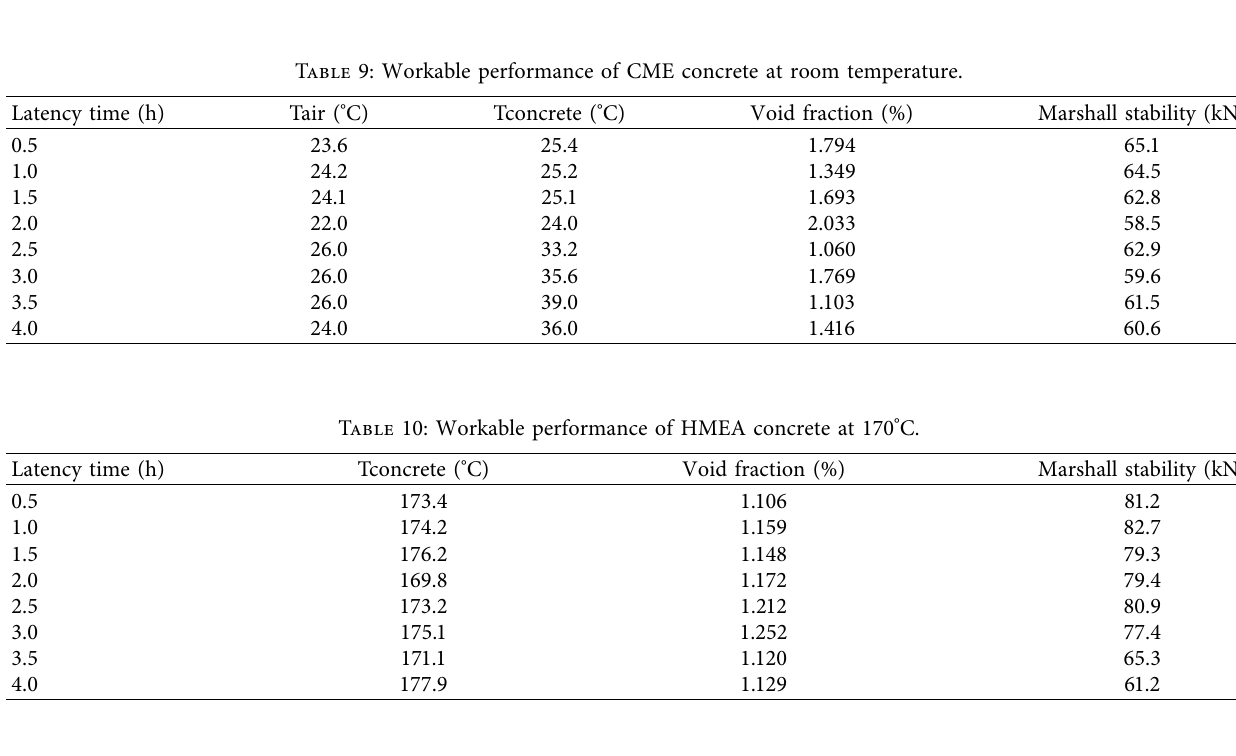
Table 11: Marshall test results of CME, HME, and HMEA concretes.